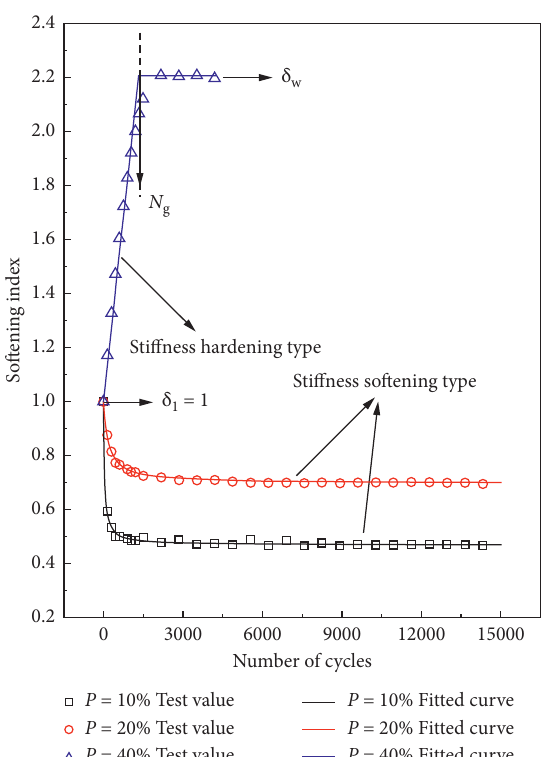
Figure 13: Fitting value of the evolution of the softening index under different rock